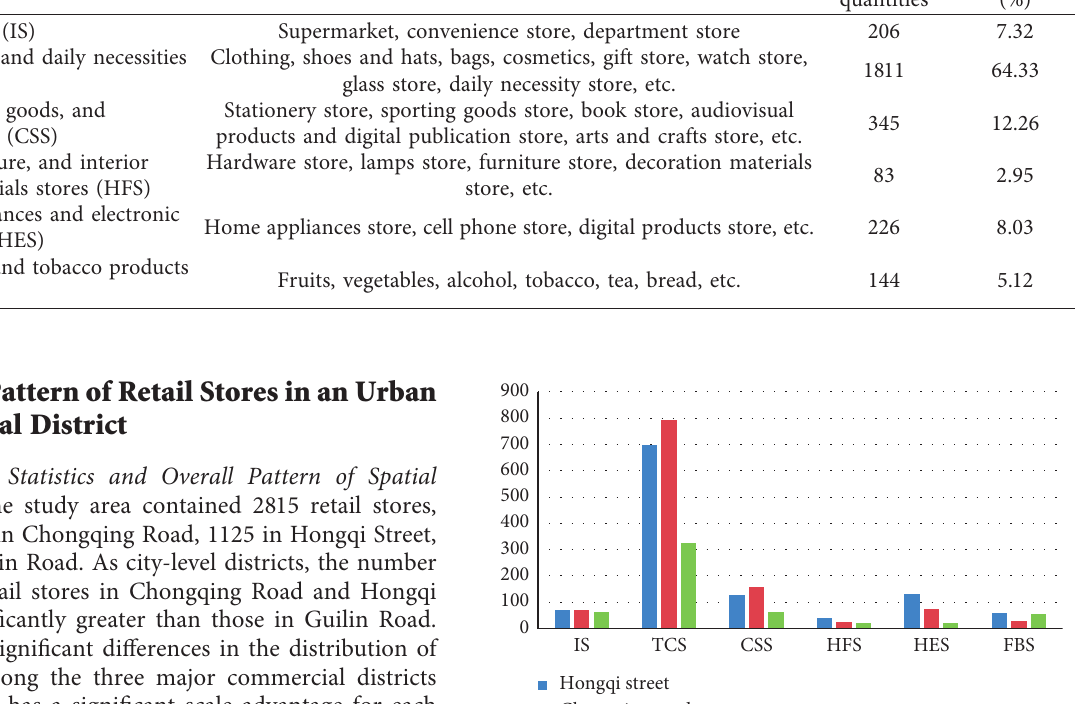
Table 1: Categories, quantities, and proportions of the retail stores in the commercial districts. Retail store categories